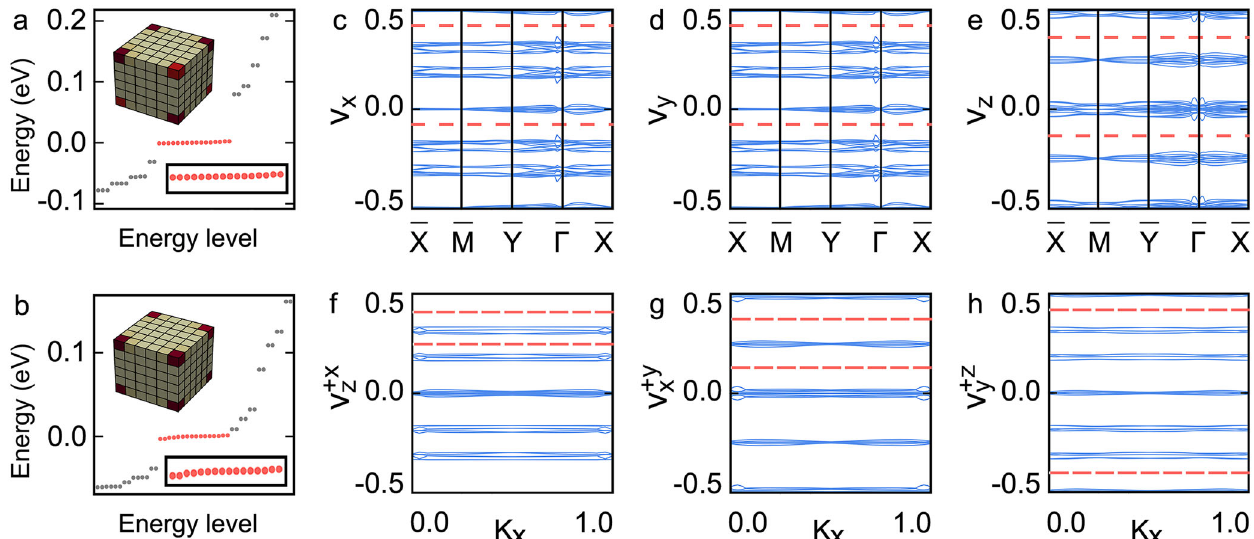
Fig. 4 Nontrivial helical corner states. Energy levels of a fi nite lattice composed of 6 × 6 × 6 conventional unit cells for a , Tl 4 PbTe 3 and b, Tl 4 SnTe 3 . There are 16 degenerate corner states as indicated with red color, which is magni fi ed in the inset of a , b . Insets show the probability of one corner state, where we sum all contributions of probability in one unit cell and each unit cell is represented with a cubic. c – e 1 st order Wilson bands v x , v y , and v z of the occupied bulk bands. The generalized ’ Fermi levels ’ are indicated with red dash lines, where we take the 1 st order Wilson bands among the two red lines as occupied 1 st order Wilson bands. f – h 2 nd order Wilson bands v þ x occupied 1 st order Wilson bands. The generalized ‘ Fermi levels ’ are indicated with red dash lines, where we take the 2 nd order Wilson bands among the two red lines as occupied 2 nd order Wilson